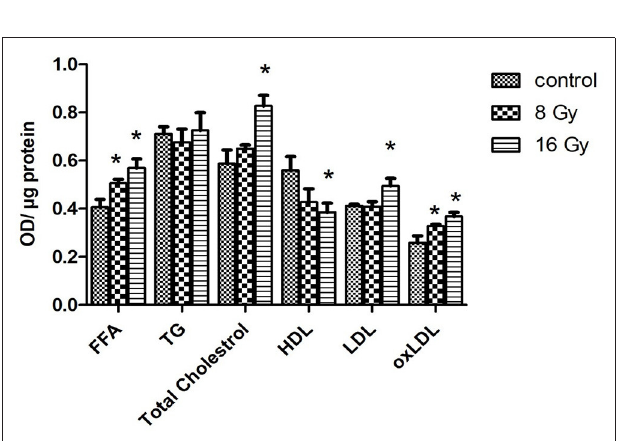
FIGURE 5 | The ELISA analysis of serum lipid levels. The levels of free fatty acid (FFA), triglyceride (TG), total cholesterol, HDL, LDL, and oxidized low-density lipoprotein (oxLDL) were measured in 100 µ g of serum of mice at 8- or 16-Gy local heart irradiation using ELISA ( t -test; * p < 0.05, mean with SEM, n =